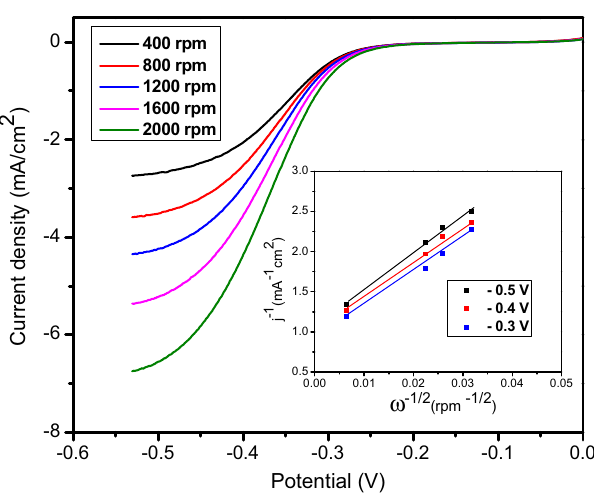
Figure 8. LSV studies of mesoporous α -Fe 2 O 3 @g-C 3 N 4 -NCs for ORR with the rotation from 400–2000 rpm at 25 mV/s. Inset shows the K-L plots of mesoporous α -Fe 2 O 3 @g-C 3 N 4 -NCs for ORR at the potential from − 0.30 to − 0.50 V vs